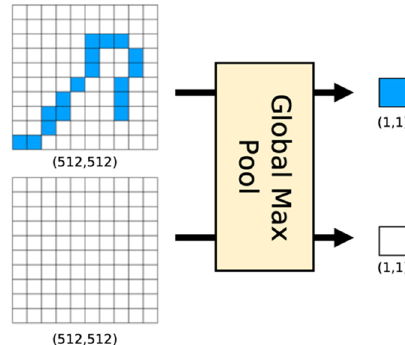
Figure 5. Max pooling operation for boundary labels 1 ( top ) and 0 ( bottom ). If there exists at least one pixel with boundary label 1, it is labeled with 1.